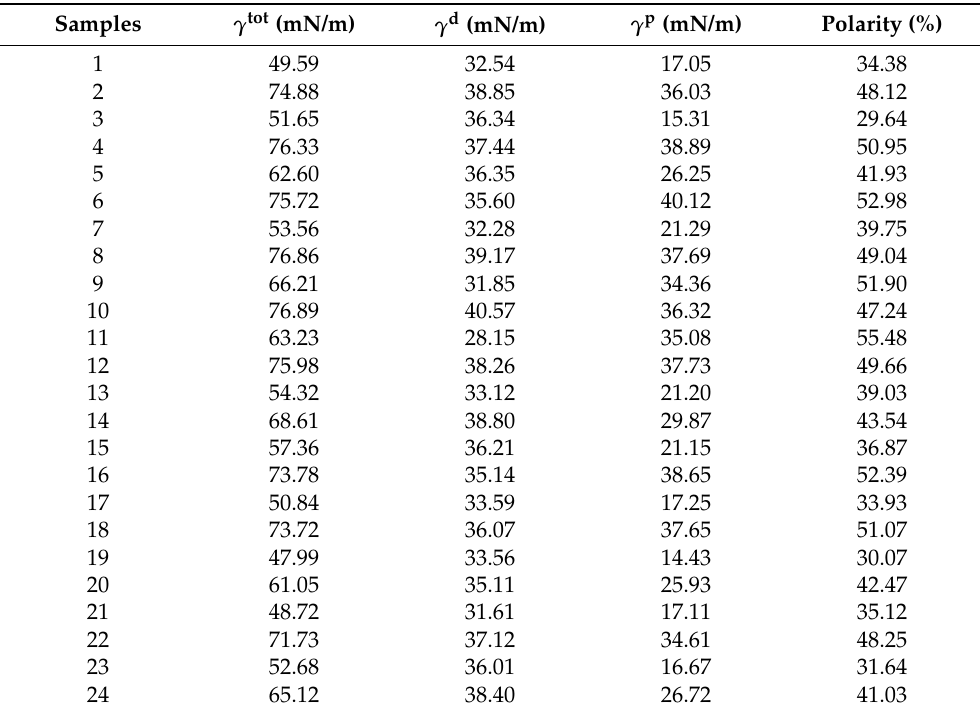
Table 4. Surface free energy ( γ tot ), dispersive ( γ d ), and polar part ( γ p ) of SFE and the polarity (%) of prepared